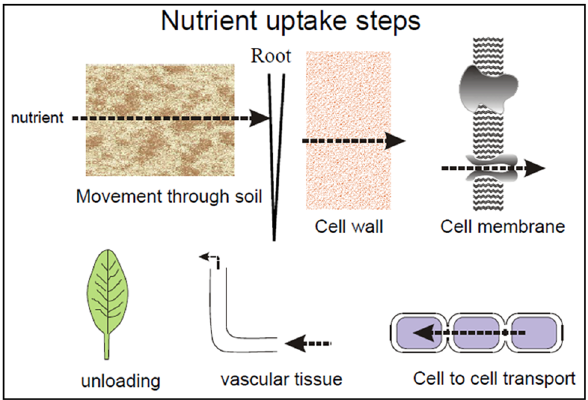
Figure 4: Mechanism of the transport pathway of a metal ion from soil to the grain.